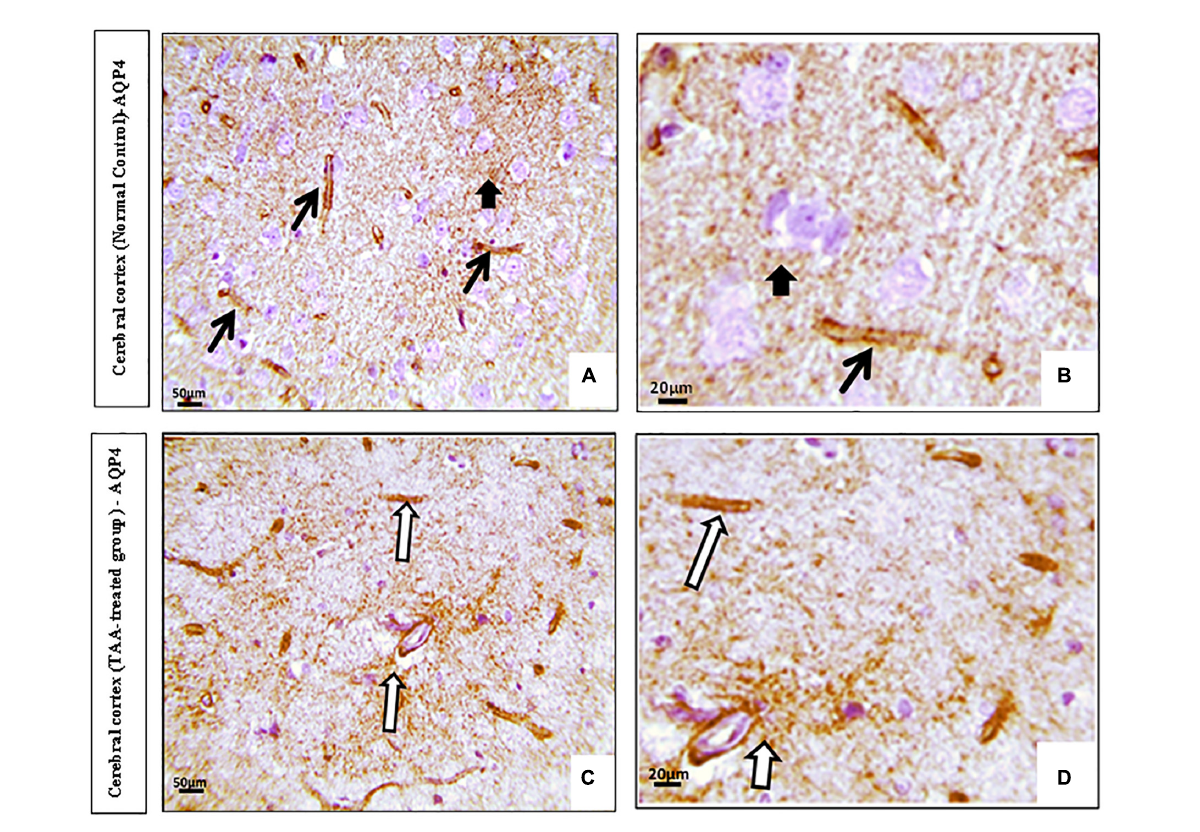
FIGURE9 (A,D) Microscopic pictures of immunostained cerebral cortical sections against (AQP4) of control and treated groups. (A,B) Control group showing expression (black arrows) in the blood vessels and membranes of astrocytes (short arrow). (C,D) Cerebral cortical sections from the TAA-treated group showing increased positively brown stained blood vessels (white arrows). X: 400 bar 50 and X: 1000 bar